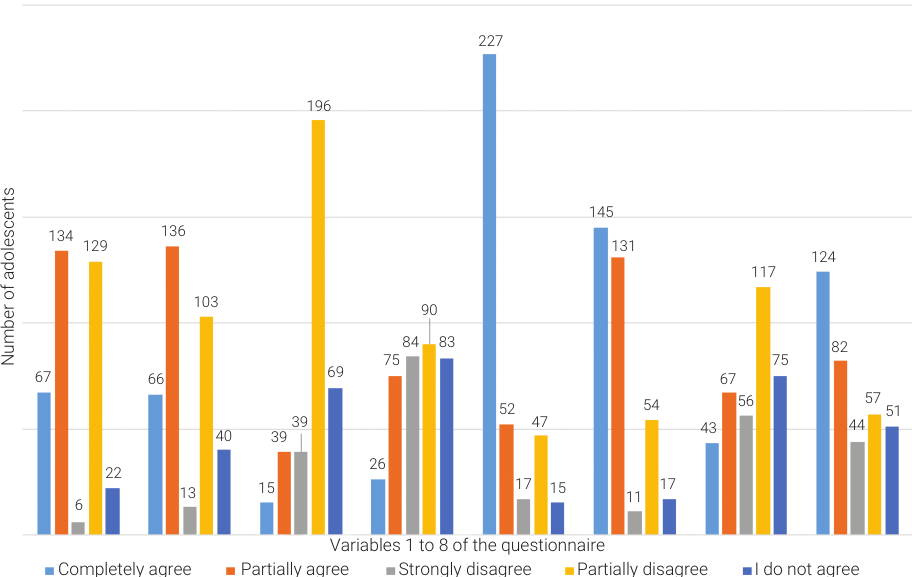
Figure 3. Number of adolescents of G2 who answered the 8 variables of the questionnaire (1 to 8) according to the Likert